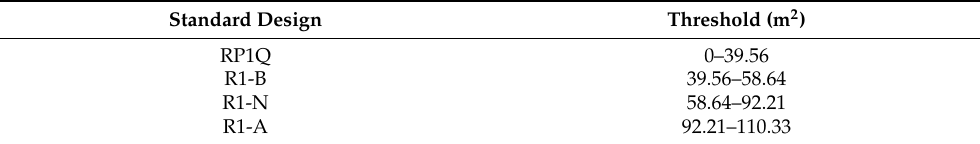
Figure 5. Lots and blocks vectorized. Table 4. Thresholds of roof area for standard design classification.